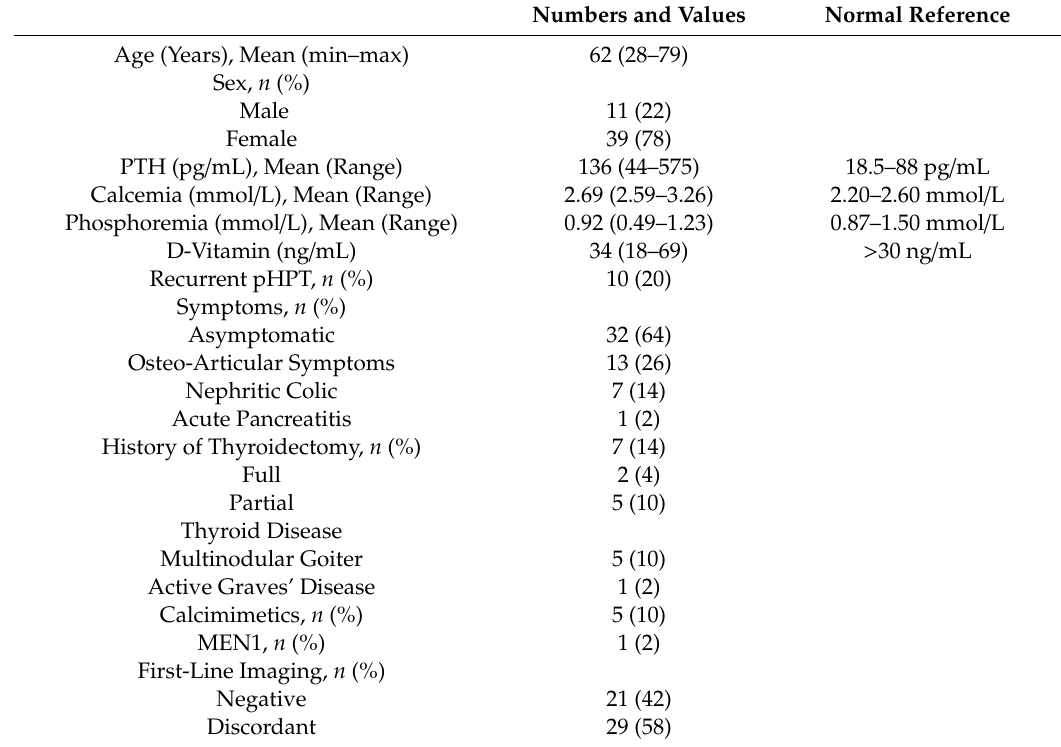
Table 1. Patient population